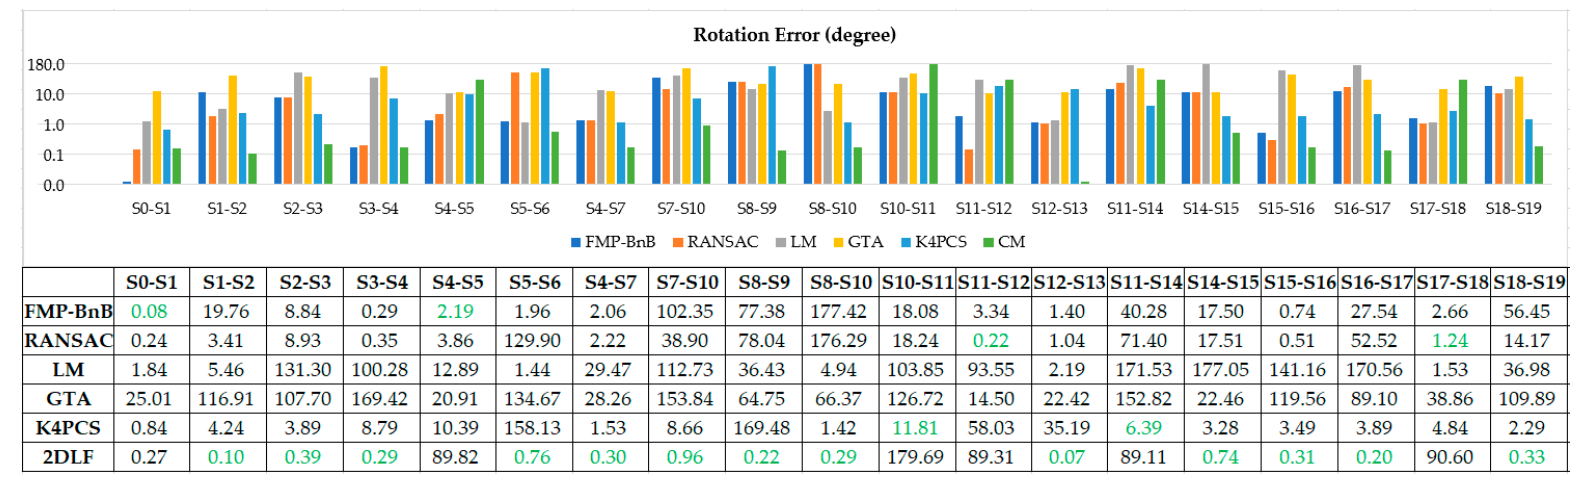
Figure 9. Translation error of point cloud pairs from dataset CB (the best result of each pair is colored in green).